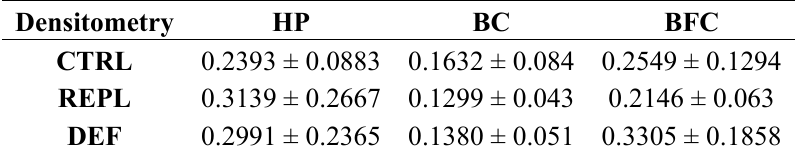
Table 3. The exact SVCT2 densitometry mean values